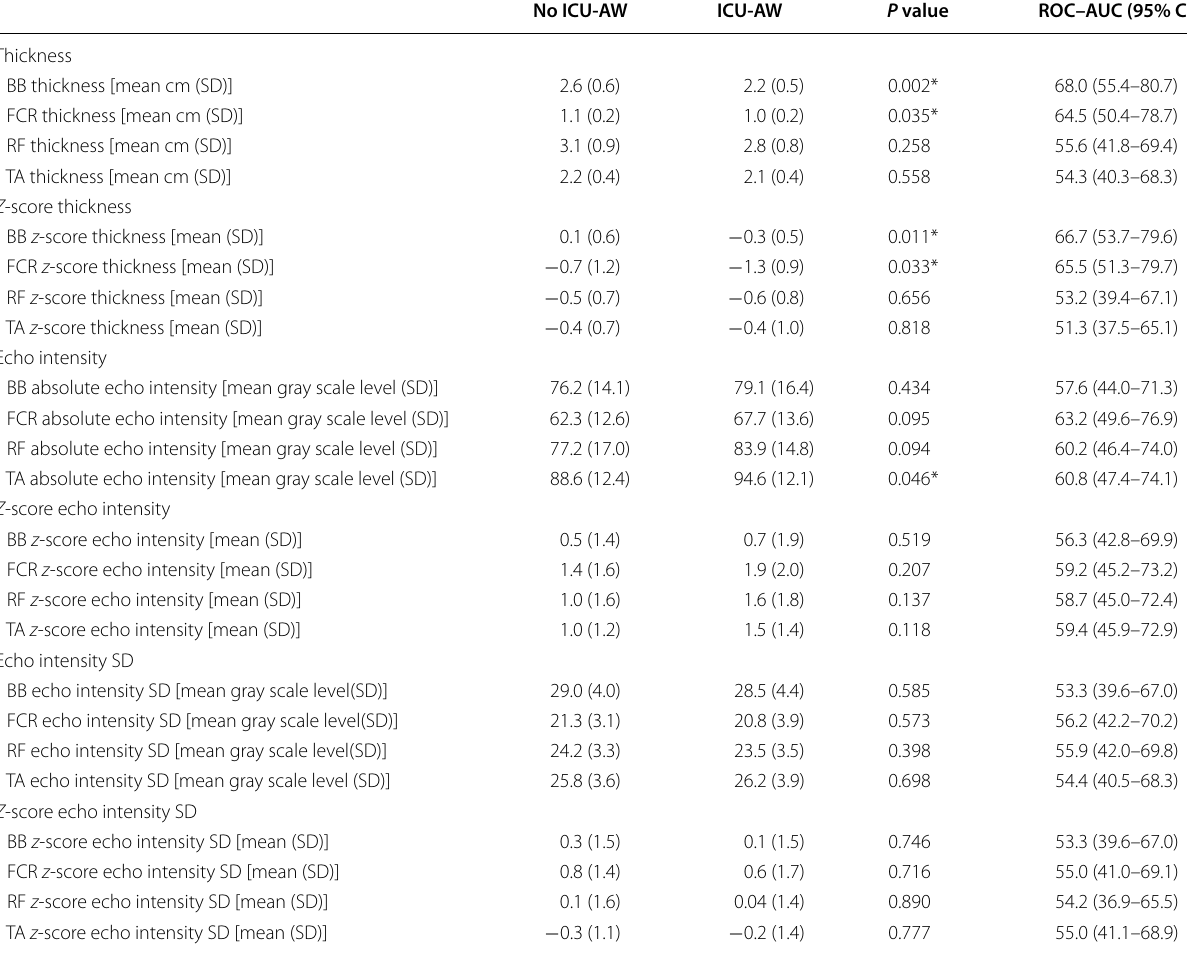
Table 2 Univariate analysis of muscle thickness, echo intensity and echo intensity standard deviation (SD) and z-scores, and area under the receiver operating characteristic curve (ROC–AUC)